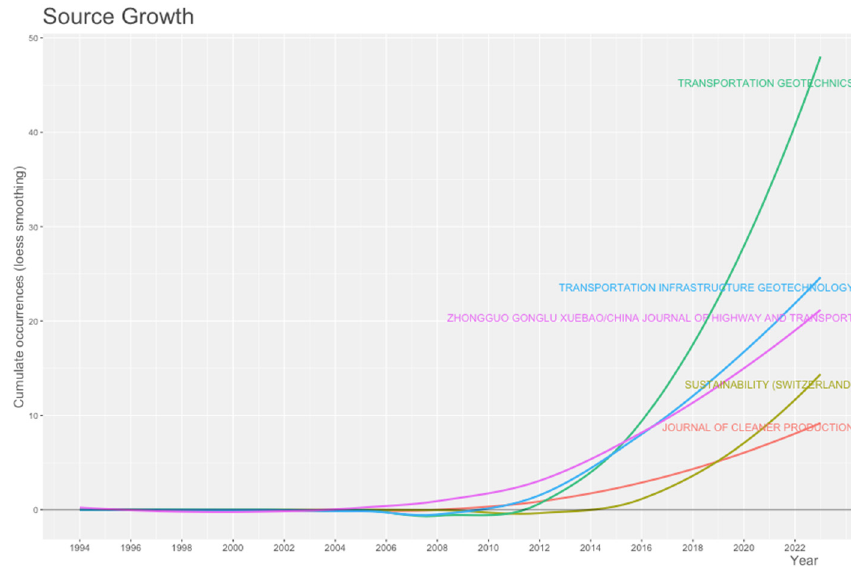
Figure 16. Cumulated source dynamics.